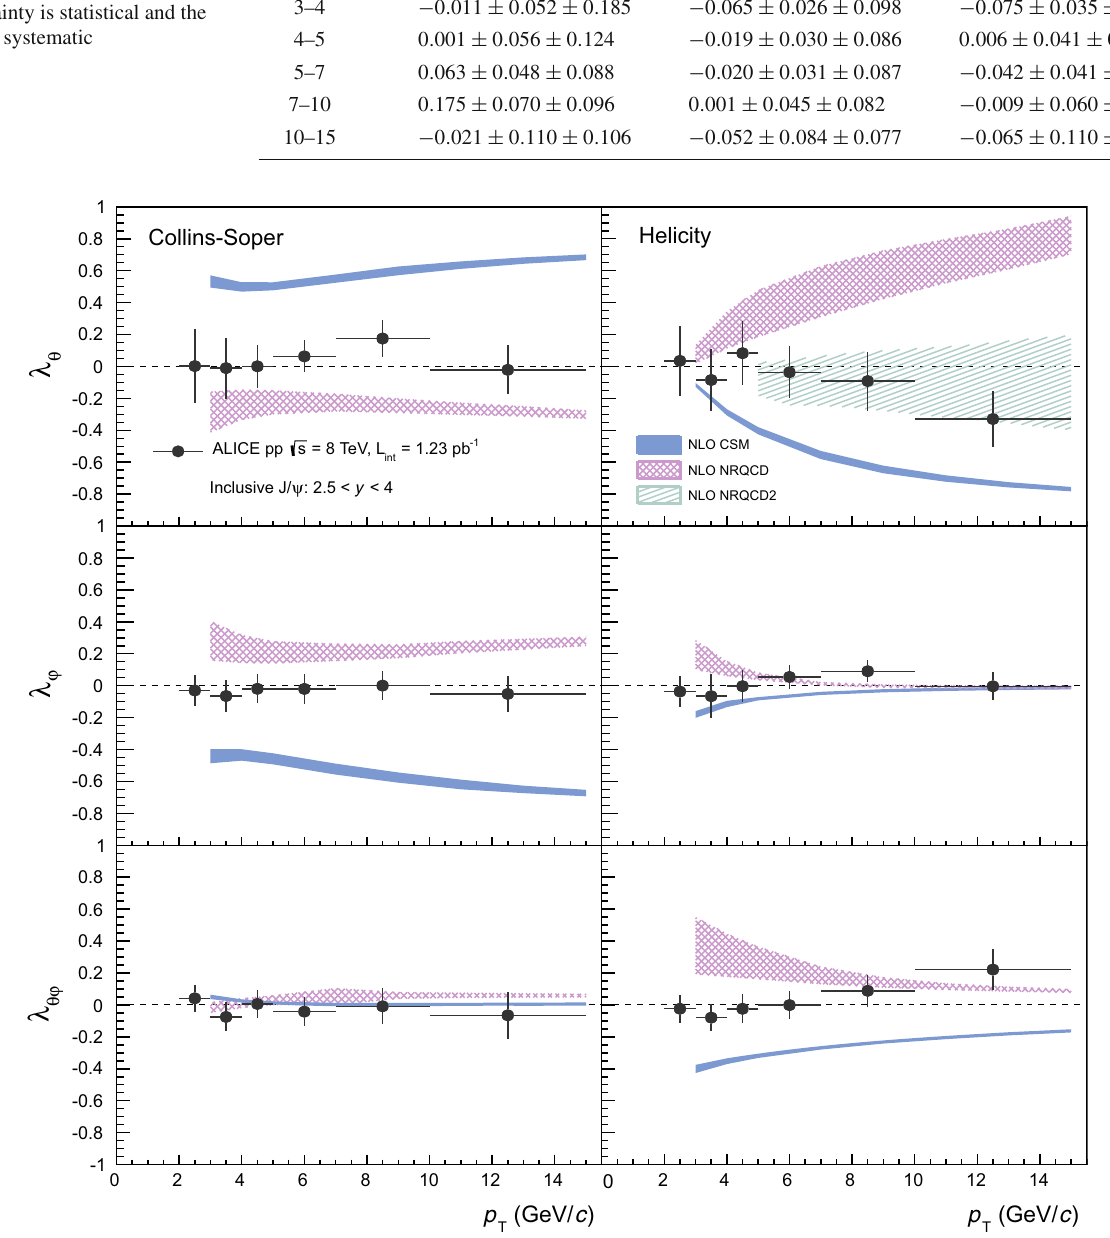
√ s = band). Left and right plots show the results in the Collins-Soper and helicity frames, respectively, for λ θ (top plots), λ ϕ (middle plots) and λ θϕ (bottom